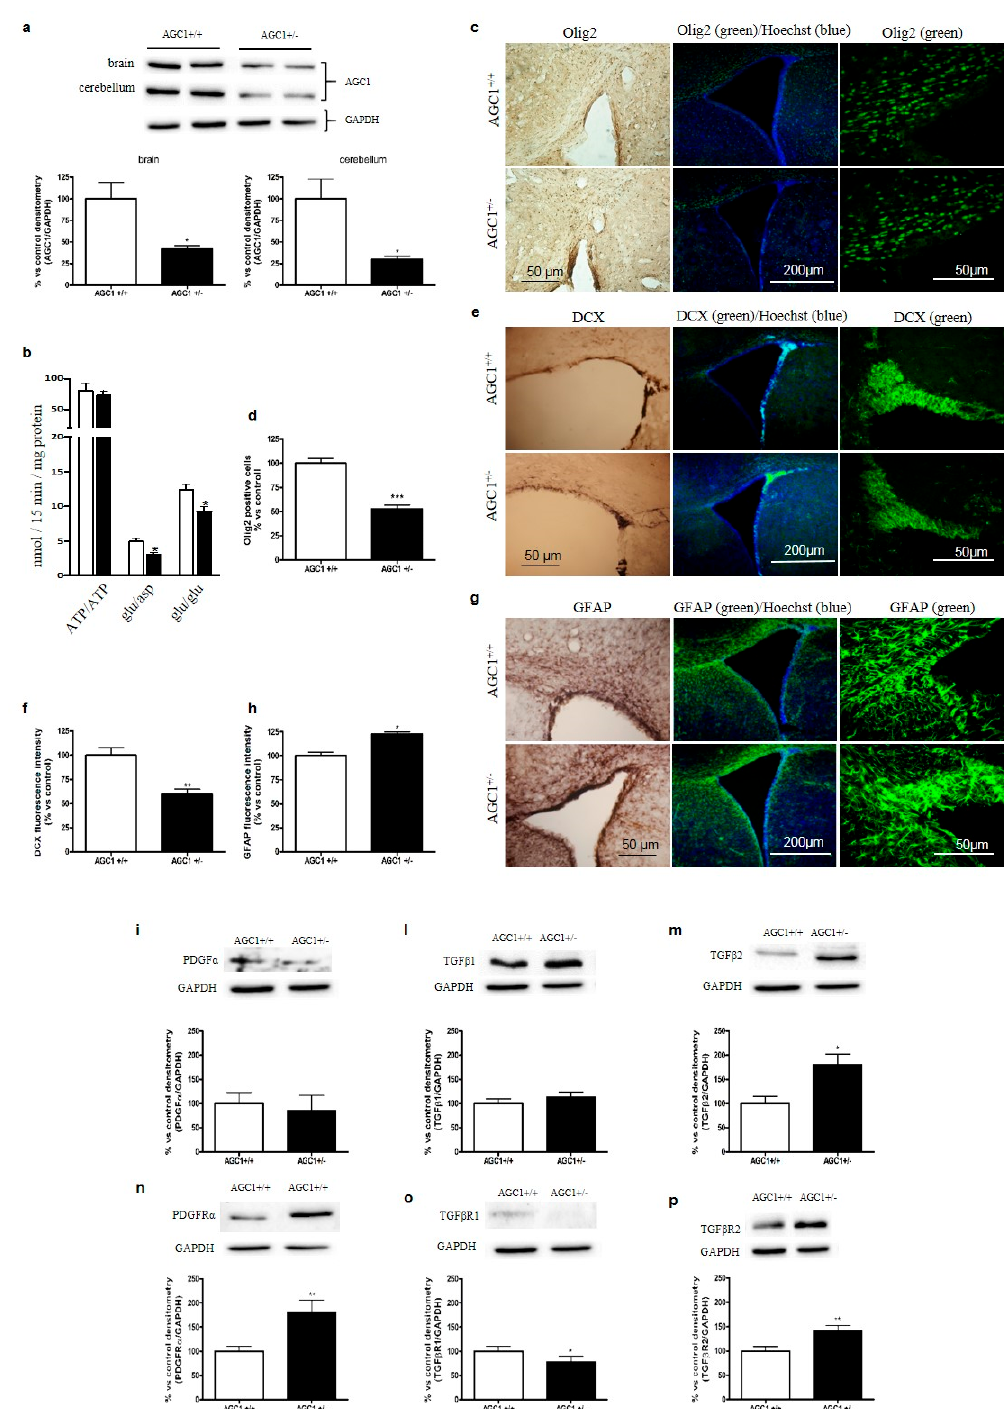
Figure 5. Proliferation deficits and dysregulation of PDGF α and TGF β pathways in 21-day old AGC1 +/ − mice. Western Blot analysis of AGC1 expression in 21-day old AGC1 +/+ ( n = 8) and AGC1 +/ − ( n = 8) mice in brain and cerebellum ( a ). GAPDH was used as reference loading control. Respective densitometric analyses are shown below. Bars represent the mean ± SE of 3 independent experiments performed in triplicate, * p < 0.05, compared to AGC1 +/+ mice, t -test of Student. ( b ) Transport activities in brain mitochondria. [ 14 C]ATP ext / ATP int (0.1 mM ext / 20 mM ext), [ 14 C]aspartate ext / glutamate int (0.05 mM ext / 20 mM ext) and [ 14 C]glutamate ext / glutamate int (0.1 mM ext / 20 mM ext) were assayed in liposomes reconstituted with mitochondrial protein extracts isolated from AGC1 +/+ (white column)